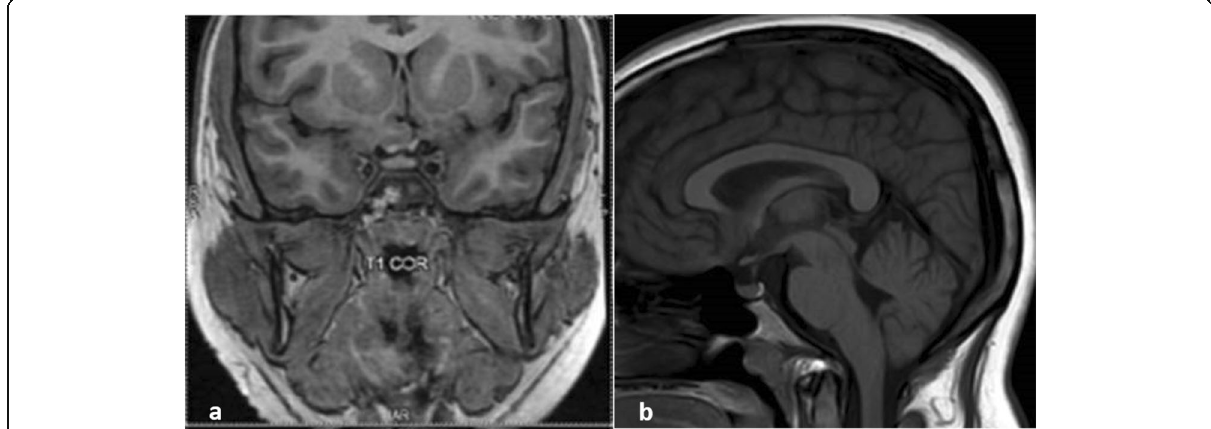
Fig. 2 a , b T1 weighted coronal and sagittal MR images of the brain through sella showing normal-sized sella turcica and anterior pituitary gland. The posterior pituitary bright spot is seen within the sella. The infundibular stalk is in the